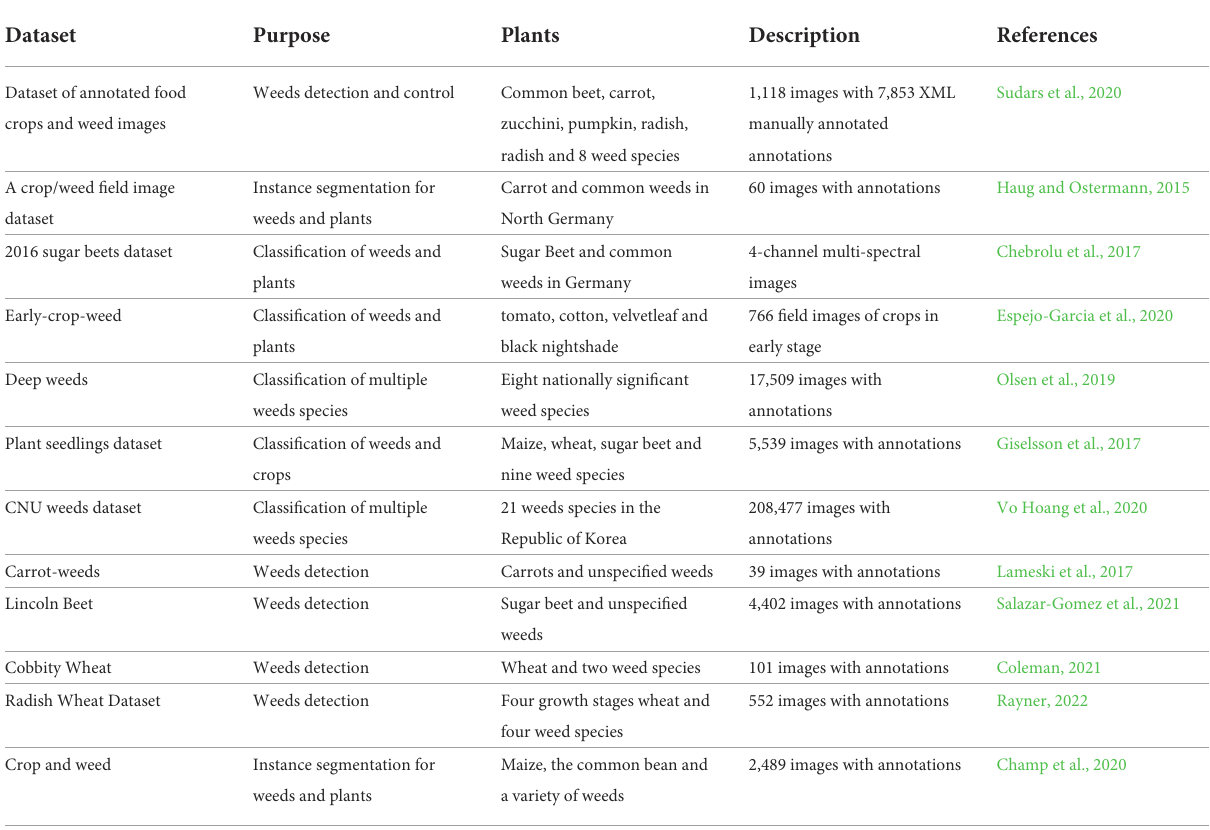
TABLE 1 Public weed datasets in crop